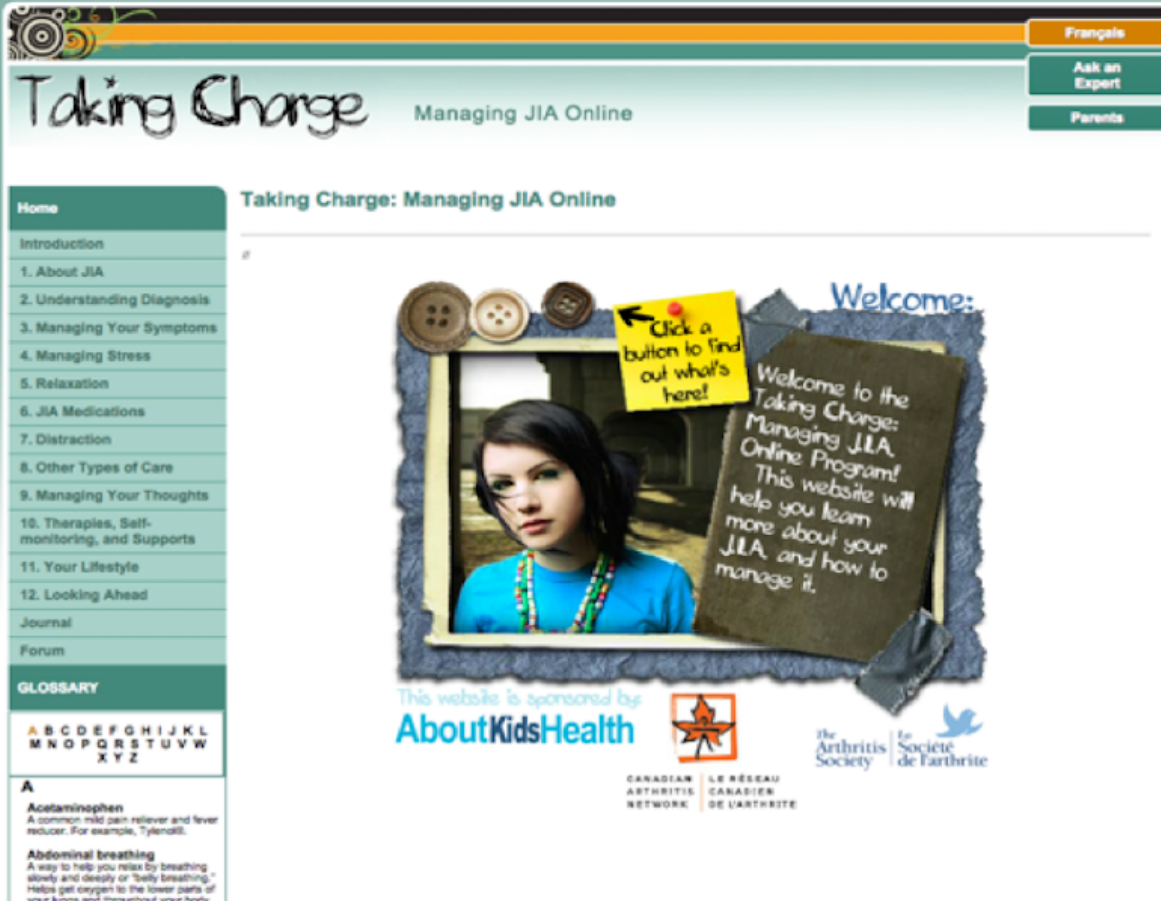
Figure 2. An example screenshot of the Teens Taking Charge: Managing JIA Online adolescent Web